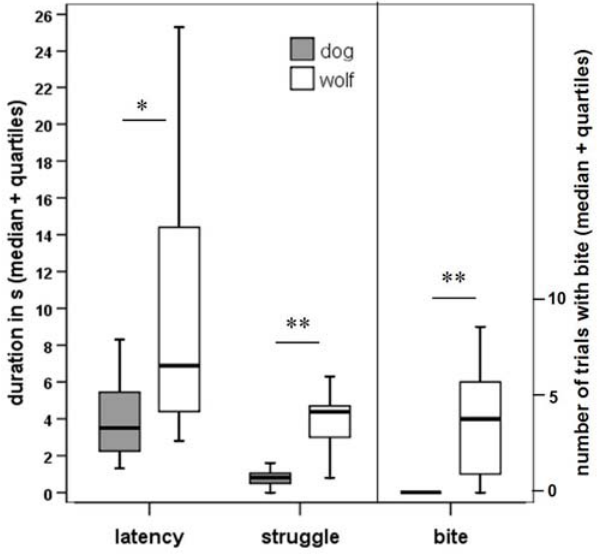
Figure 2. Study 1: The behaviour of 8-week-old, hand-reared dogs (N=7) and wolves (N=9) in the proximal momentary pointing test. * P , 0.05, ** P , 0.01.